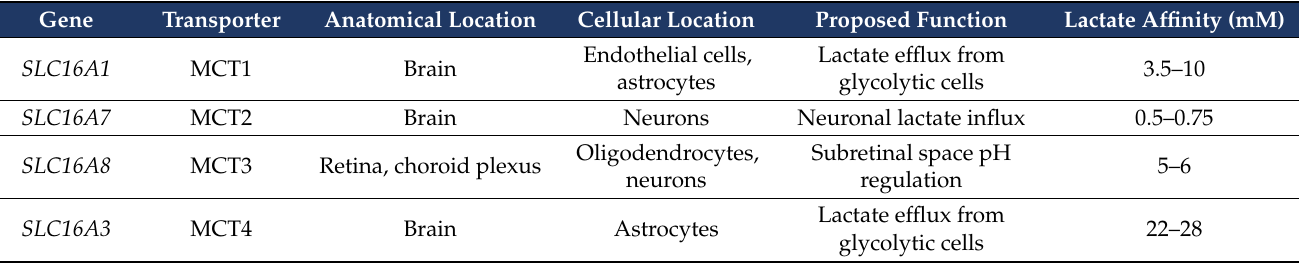
Table 2. MCTs in the human nervous